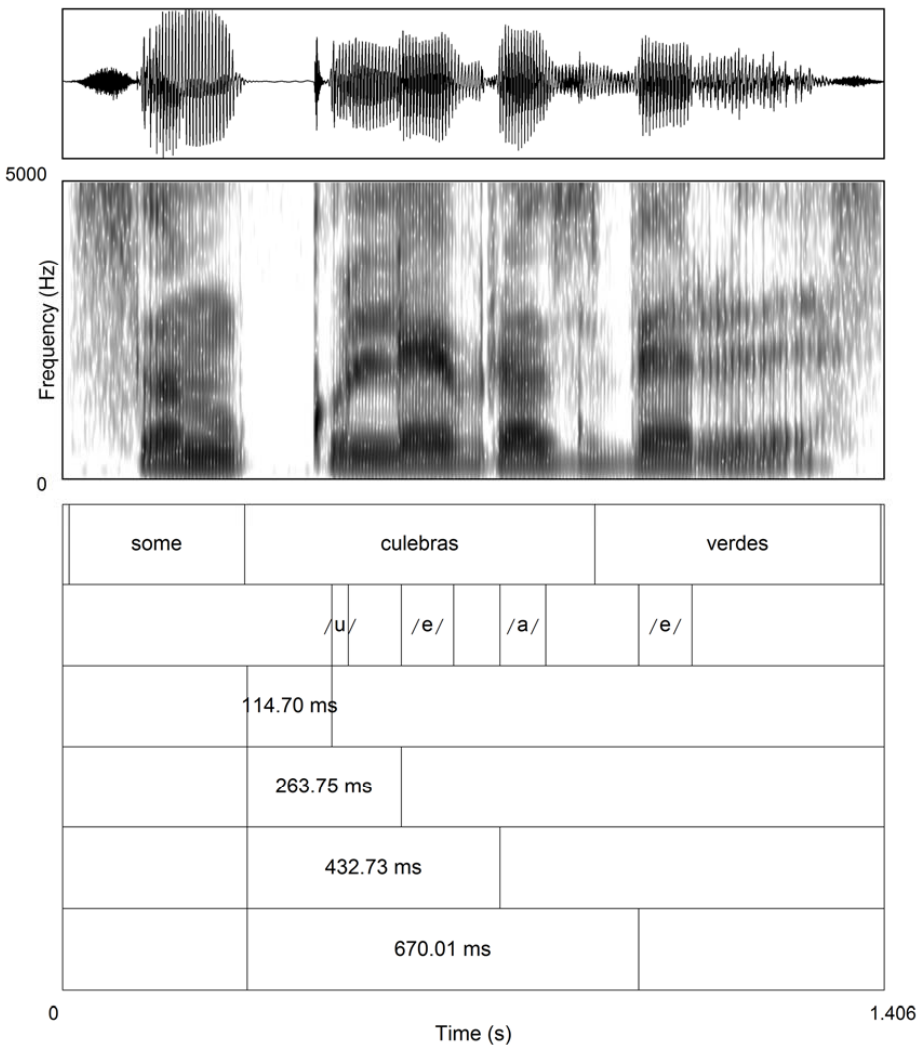
Figure 1. Example of how distance from the code ‐ switching site was measured with the English ‐ to ‐ Spanish intra ‐ sentential code ‐ switch some culebras verdes ‘some green